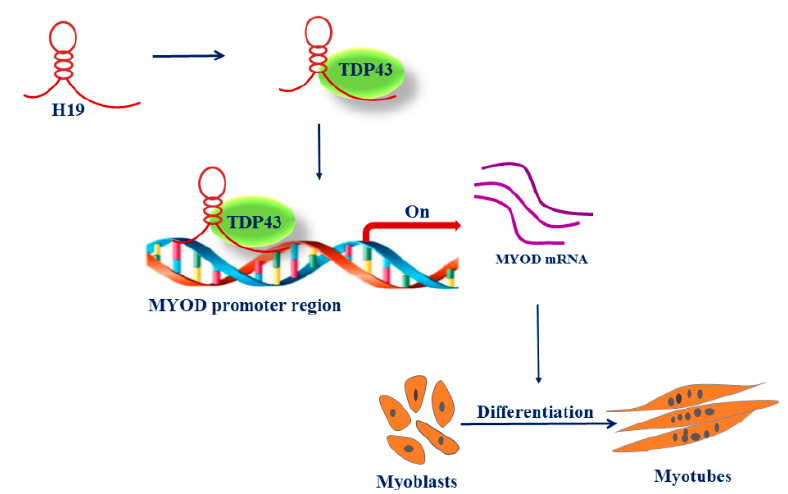
Figure 5. Model for H19-regulated PSC differentiation.